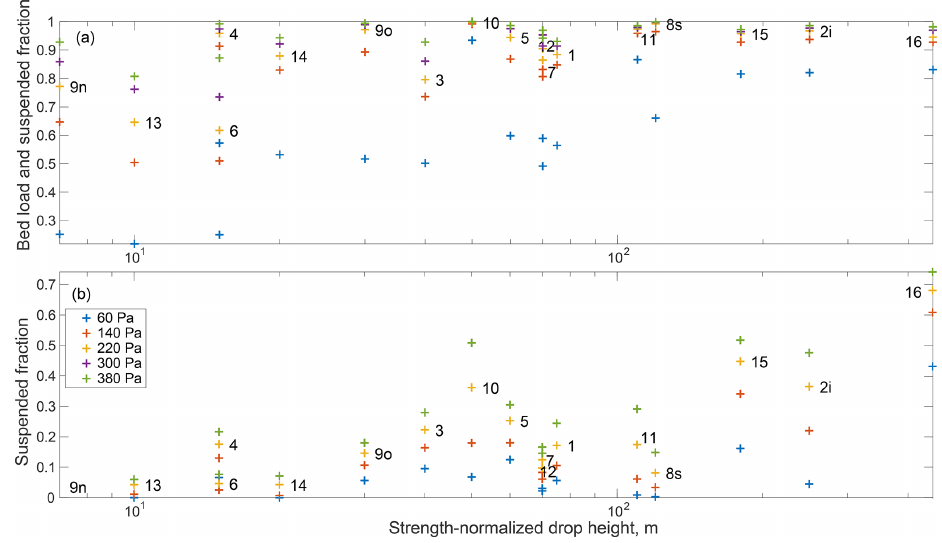
Figure 7. Fraction of the landslide GSD that could be transported as both bed load and suspended load (a) and only as suspended load (b) as a function of the strength-normalized landslide drop height (as in Fig. 4) and river shear stress during a 10-year return flood (illustrated using different colors). Note that the suspended fractions at 300 and 380Pa are identical in panel (b) .